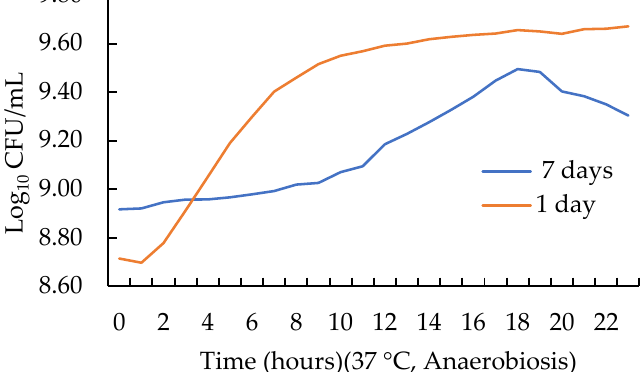
Figure 2. Effect of inoculum age on the growth curve of Lactobacillus acidophilus .